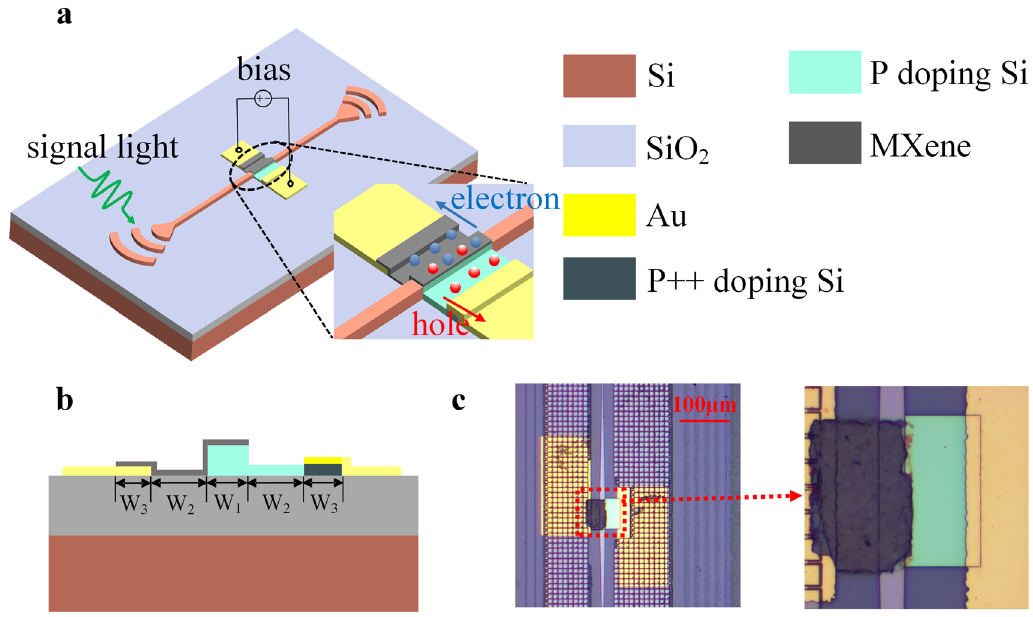
Figure 1: Structures of proposed waveguide Schottky photodetector. (a) The whole structure is based on an SOI chip with a p doping silicon rib waveguide. The Ti 3 C 2 T x fi lm is deposited on the side of the doped waveguide without a ridge layer and covers the whole doped silicon waveguide and part of the gold electrode. (b) The cross-section of the proposed photodetector. (c) Microscope image of the proposed